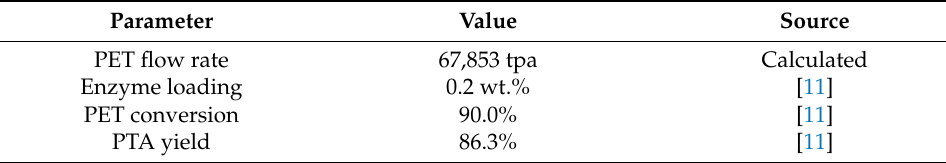
Table 1. Specifications for mass balances and conversions in Area 1.